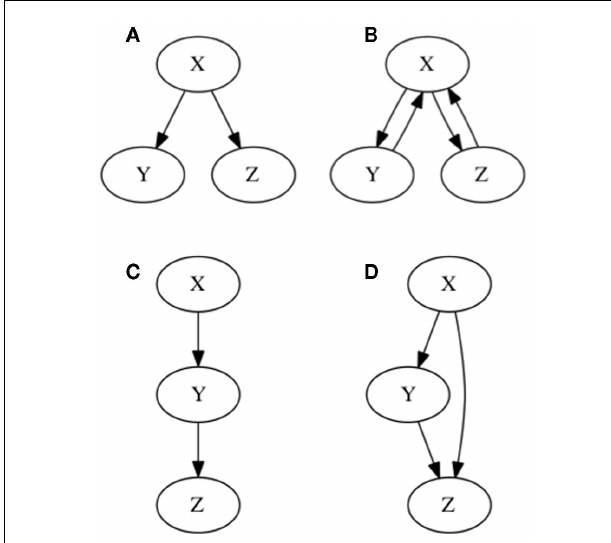
FIGURE 1 | Graphical representation of hierarchical and single-path notions of gene regulation. In (A) hierarchical gene regulation is represented. As observed all nodes are either “upstream,” “downstream,” or at the same level. Consequently X regulates Y and Z , but X is not regulated by either Y or Z . No gene can by upstream and downstream at the same time. In (B) two feedback loops are included, by assuming that Y and Z regulate X . Hence, it is not possible to establish a hierarchy on gene regulation, since all genes can by upstream and downstream at the same time. In (C) a single-path gene regulation pattern is represented. In (D) a feed-forward loop is incorporated yielding two alternative pathways starting at X : one is a direct regulation of Z , and the other one implies an indirect regulation of Z , via Y .